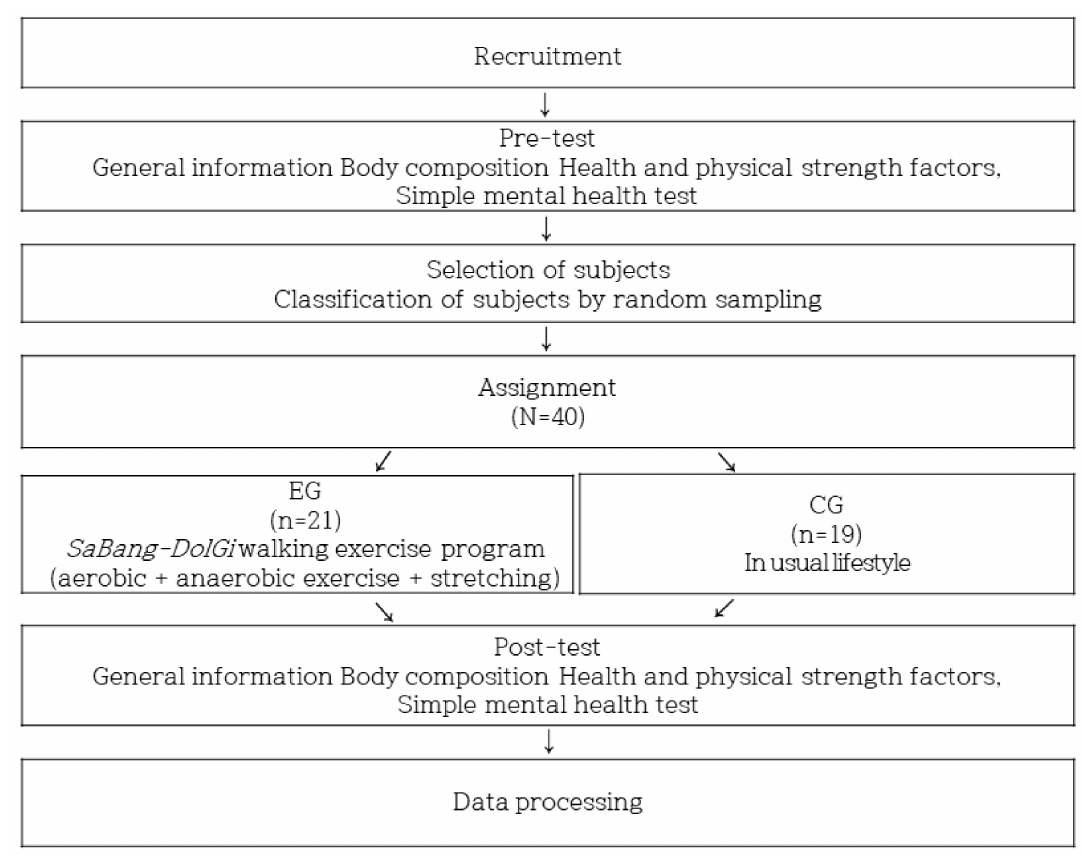
Figure 2. Participant allocation (flow diagram of the consolidated standards for the reporting of